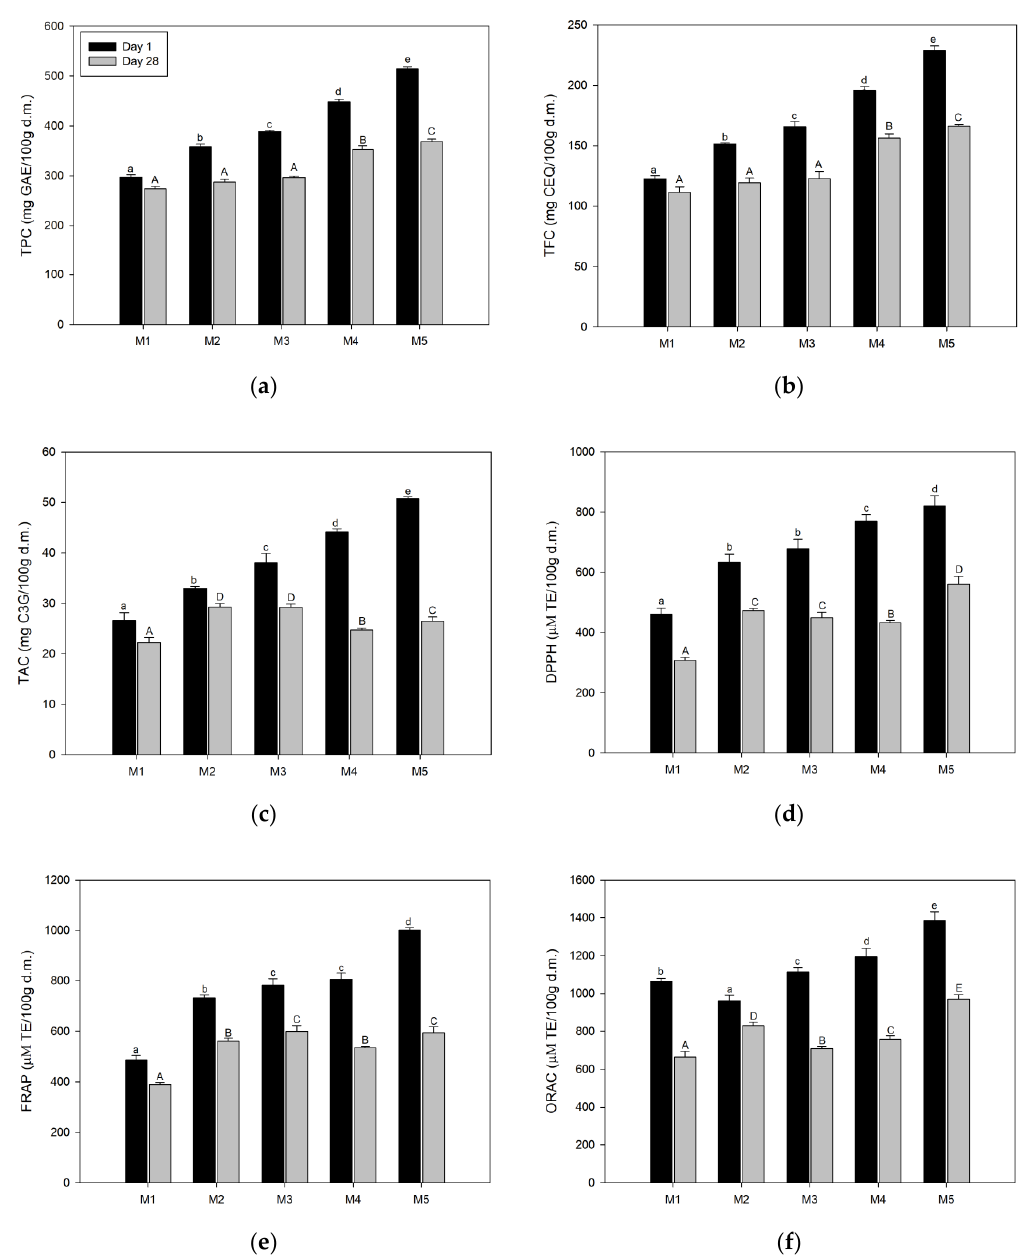
Figure 5. Total bioactive compounds content (TBCC) and antioxidant activity (AA) in aerated CBJ–gelatin gels at day 1 and day 28: ( a ) total polyphenol content (TPC); ( b ) total flavonoid content (TFC); ( c ) total anthocyanin content (TAC); ( d ) 2,2-diphenyl-1-picrylhydrazyl (DPPH); ( e ) ferric reducing antioxidant power (FRAP); ( f ) oxygen radical absorbance capacity (ORAC). a–e: Different small letters denote differences at 5% from M1 to M5 at day 1, according to the LSD test. A–E: Different capital letters denote differences at 5% from M1 to M5 at day 28, according to the LSD test.